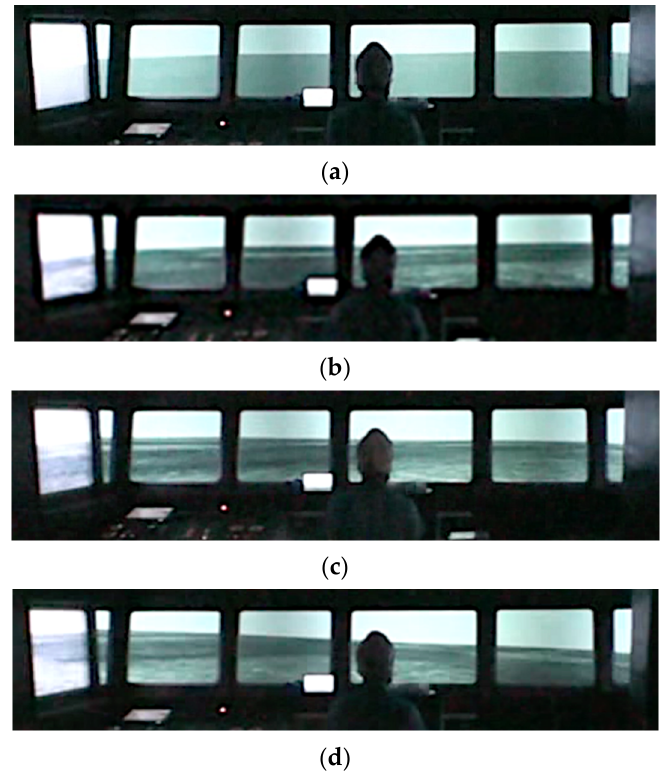
Figure 5. Simulated wave images: ( a ) Pattern 1 (images without waves); ( b ) Pattern 2 (wave direc- tion: 180°); ( c ) Pattern 3 (wave direction: 135°); ( d ) Pattern 4 (wave direction: 90°). Table 4. Motion of the simulated high-speed boat.